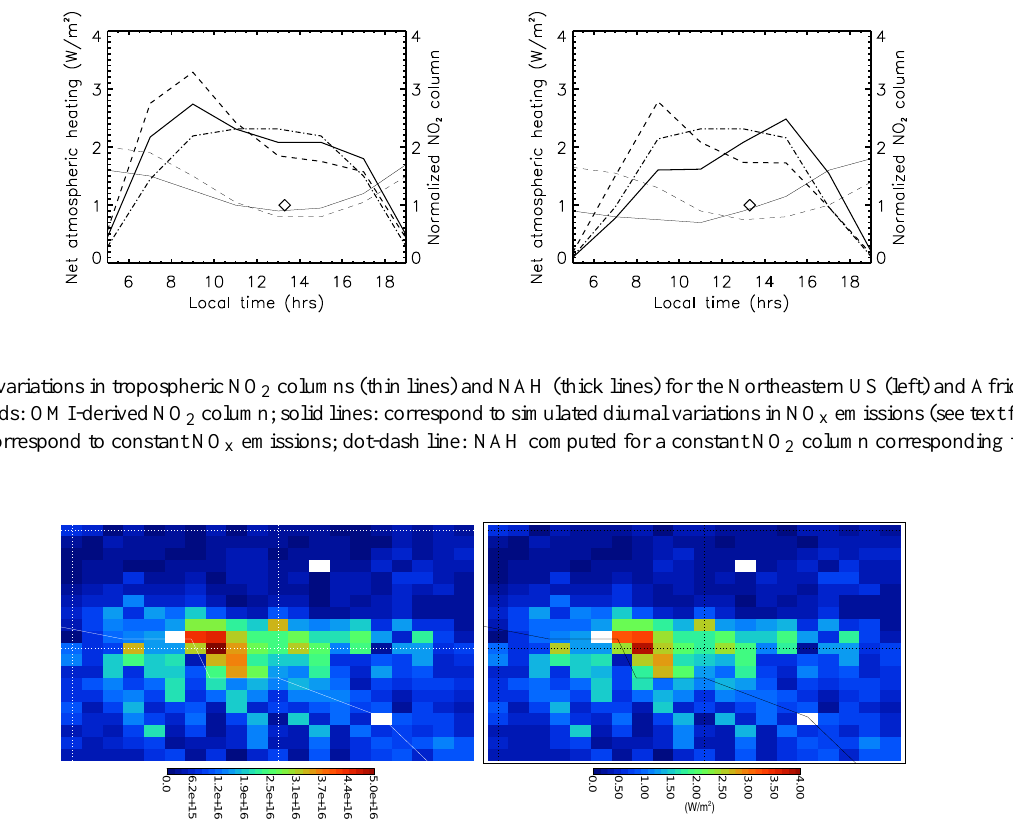
Fig. 10. Annual average NO 2 columns (left) and corresponding maximum daily NAH for 01 July (right) over Los Angeles computed with a 0.1 (cid:14) (cid:2) 0.1 (cid:14) grid.